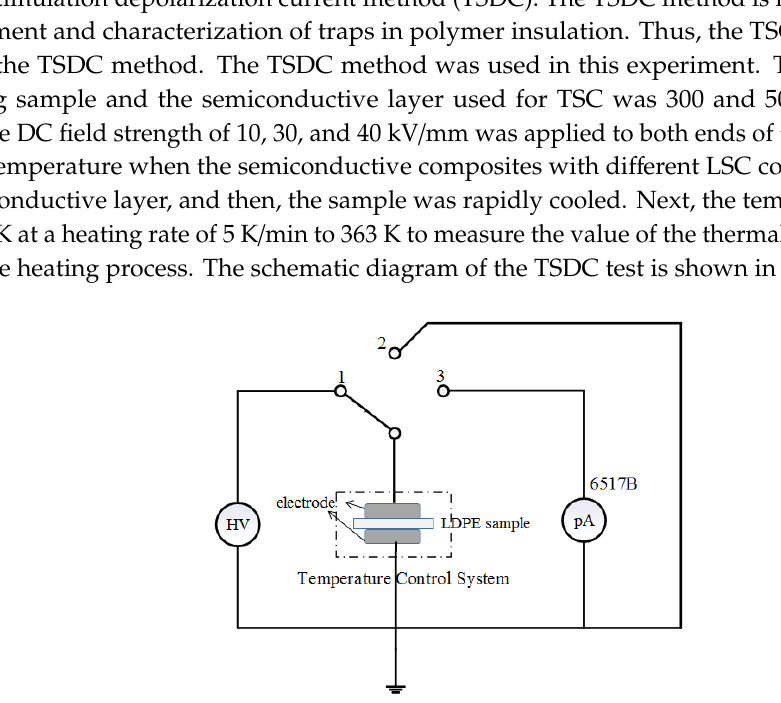
Figure 3. Schematic diagram of thermal stimulation current method.